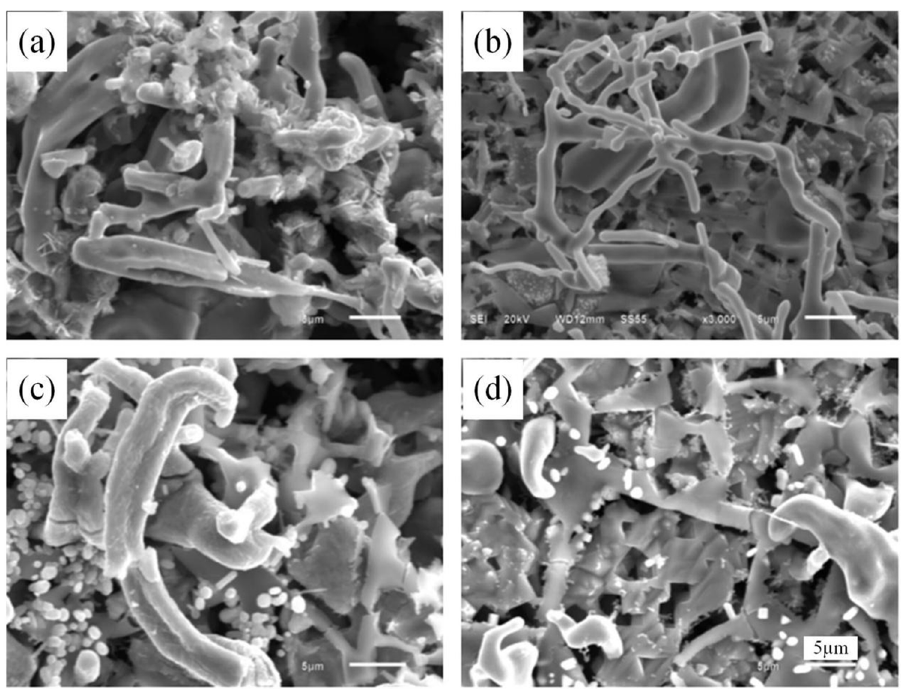
Figure 12: SEM of reduced briquettes ( R = 0.83 ) reduced for 60 min at di ff erent fi ring temperatures ( a ) 1,230°C, ( b ) 1,250°C, ( c ) 1,280°C, and ( d )